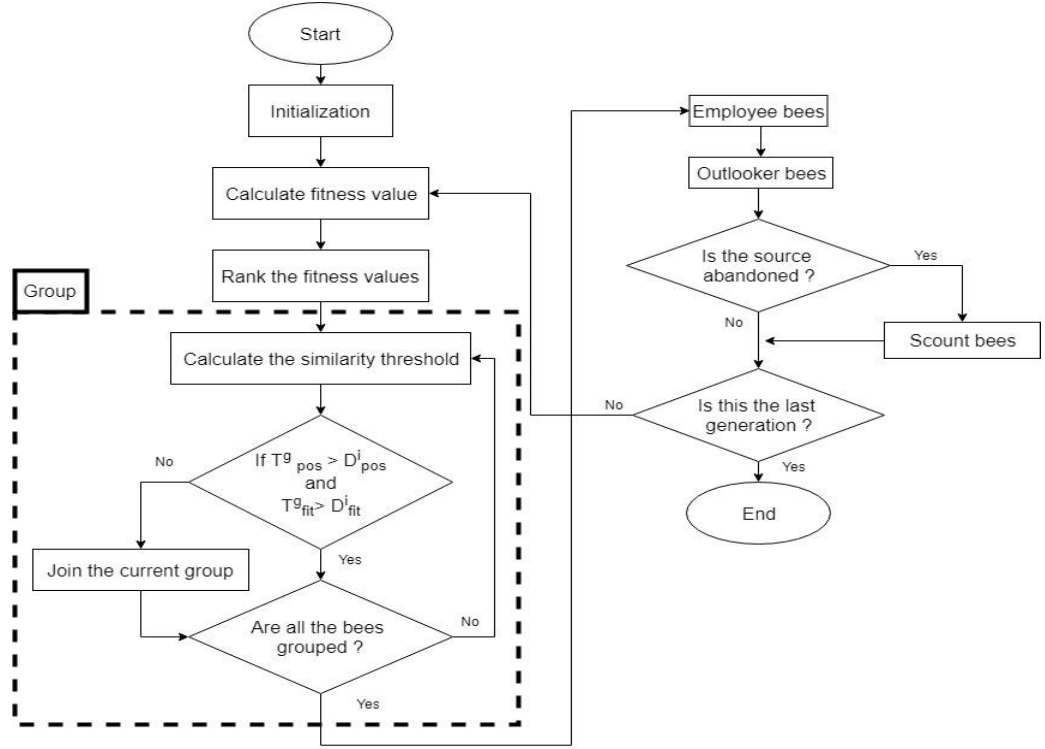
Figure 15. Flowchart of proposed hybrid of group strategy and artificial bee colony (HGSABC) algorithm.